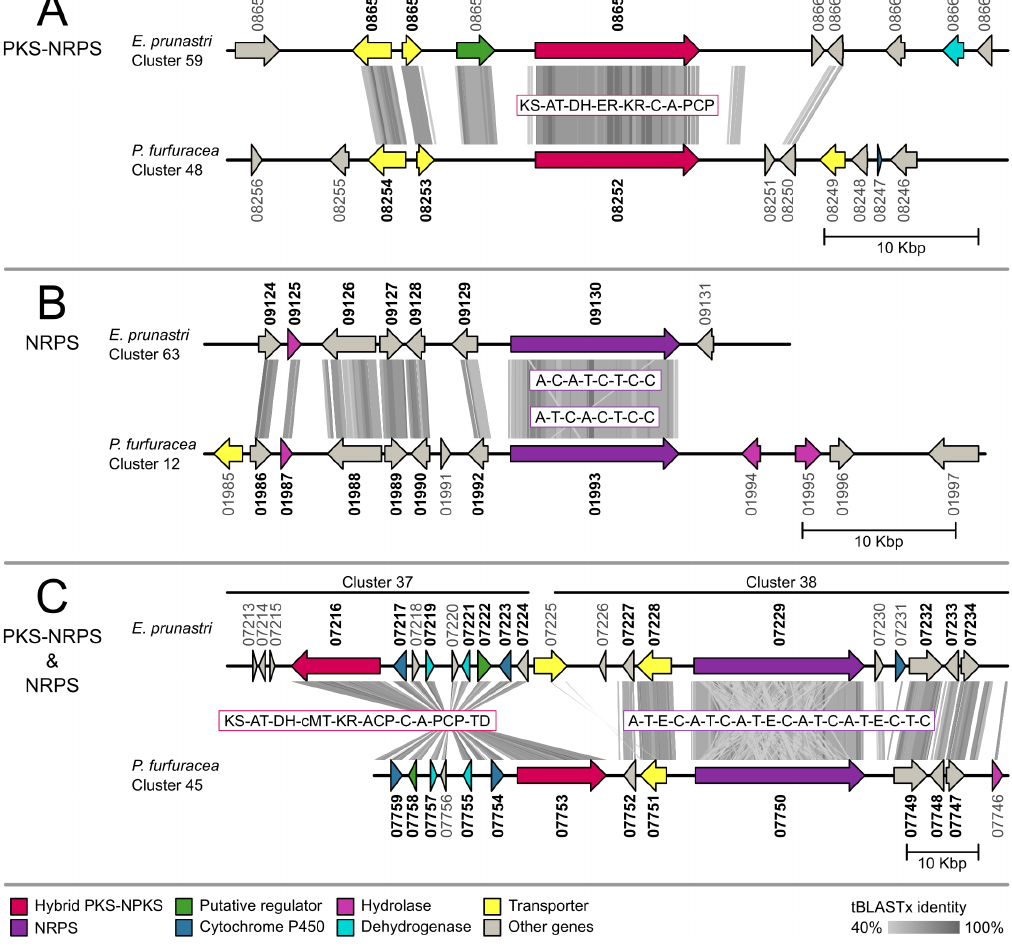
Figure 5. Synteny plots of biosynthetic gene clusters with an ortholog non-ribosomal peptide synthetase (NRPS) core gene or hybrid with polyketide synthase (PKS-NRPS) in Evernia prunastri and Pseudevernia furfuracea . Orthologous genes identified with the reciprocal best hit (RBH) approach are highlighted in bold. A = Adenylation; ACP = Acyl carrier protein; AT = Acyltransferase; C = Condensation; cMT = C-Methyltransferase; DH = Dehydratase; E = Epimerization; ER = Enoylreductase; KR = Ketoreductase; KS = Ketosynthase; PCP = peptide carrier protein; T = Thiolation; TD = Terminal